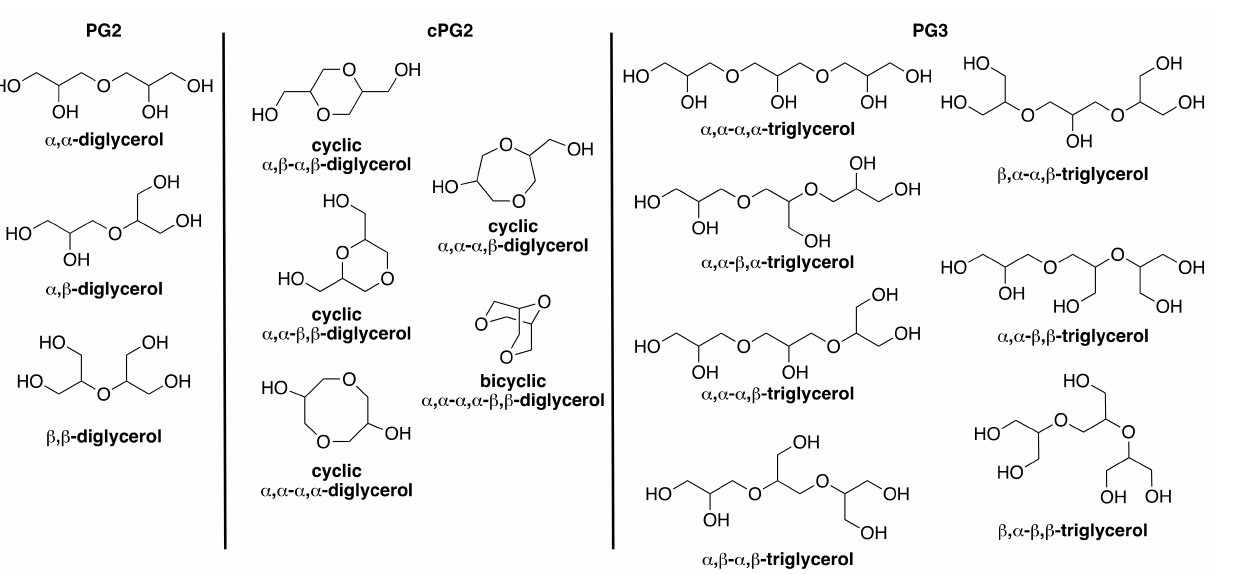
Figure 1. Linear/branched isomers of diglycerol (PG2) and triglycerol (PG3) and cyclic isomers of diglycerol